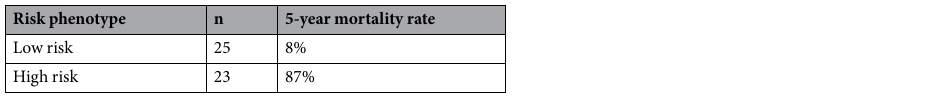
Fig. 3. In Table 3 we present the mean and the standard deviation of the AUC and accuracy results for the deep learning and the best traditional models. Comparison is also made with selected published clinical scores pre- dicting 5 year mortality. Using a t-test for paired samples there was no significant difference between the accuracy (p = 0.61) and AUC (p = 0.62) of the deep learning and best human-defined feature models. Both the deep learning model and the